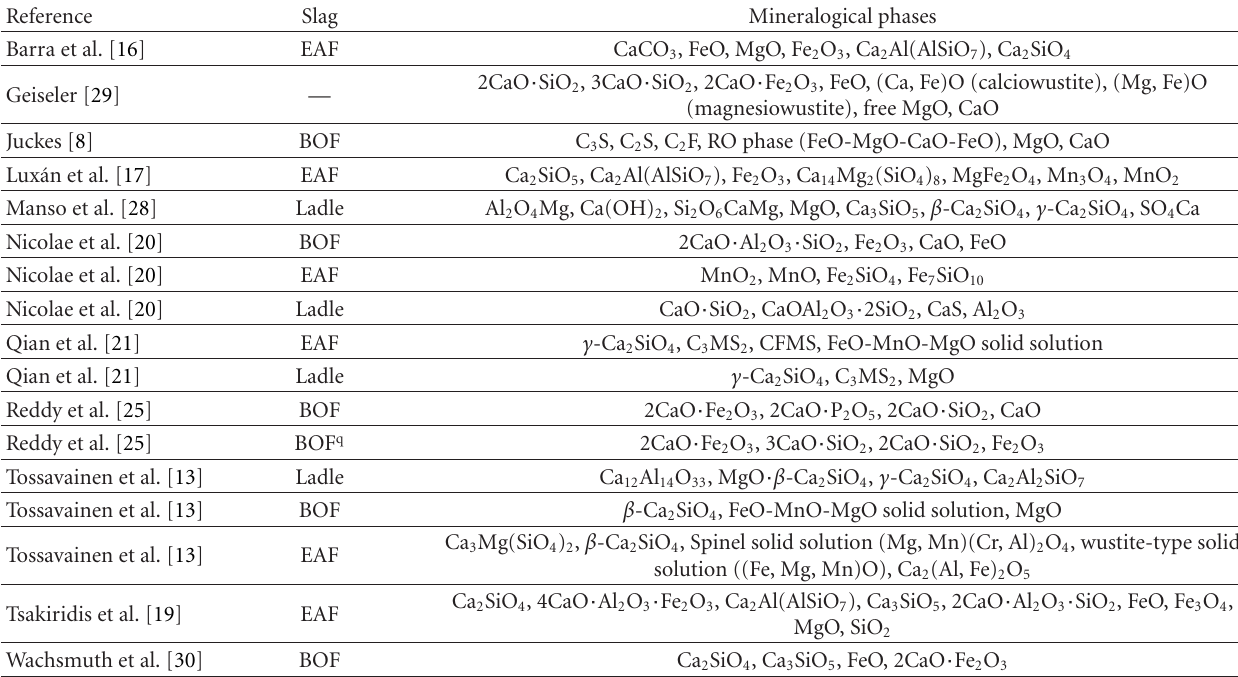
Table 2: Mineralogical phases of BOF, EAF, and ladle slags.